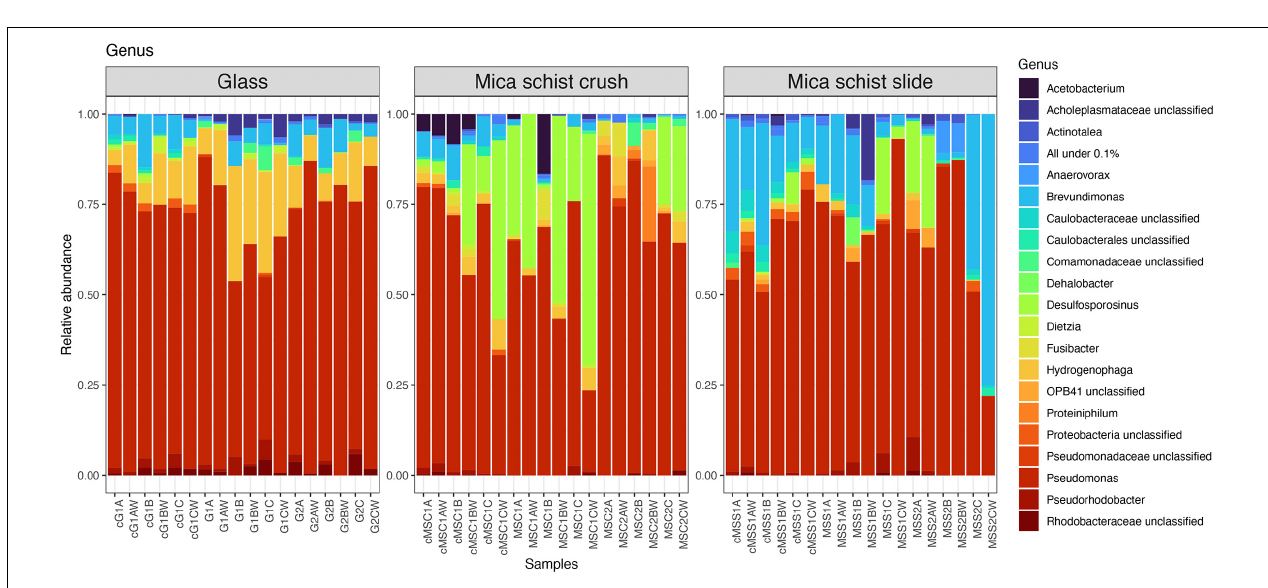
FIGURE 4 | Relative abundances of bacterial communities at genus level in different sample types. All genera below 0.1% mean prevalence were pooled as “All under 0.1%.” The letter “c” in front of the sample names indicates cDNA sample, G = Glass, MSC = Mica schist crush, MSS = Mica schist slide, time point is indicated with 1 or 2, and replicate samples are indicated with A, B, and C for biofilms and AW, BW, and CW for microcosm water phase samples.